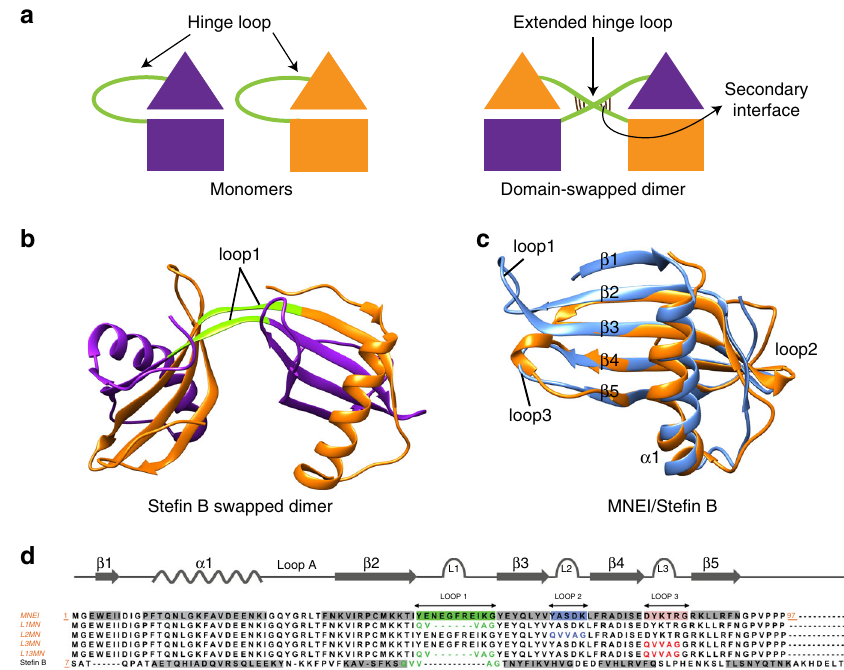
Fig. 1 Rational design of domain swapping in MNEI. a Schematic representation of domain swapping. The hinge loop, connecting the exchangeable domains, adopts an extended conformation in the swapped dimer. Each monomer-like half of the swapped dimer, formed by contributions from the two polypeptide chains (or protomers), is referred to as a “ functional unit ” . The proximal arrangement of the polypeptide chains in the domain-swapped conformation may lead to the formation of a novel intermolecular interface (secondary interface), which is not found in the monomeric structure. The secondary interface is shown in the cartoon as a set of new interactions established between the two polypeptide chains in the region of crossover. b Structure of the domain-swapped dimer of ste fi n B (PDB ID: 2OCT) is shown. The two polypeptide chains contributing to the dimer are shown in purple and orange. Sub-domains β 1- α 1-loopA- β 2 and β 3-loop2- β 4-loop3- β 5 are exchanged between the two protomers. Loop1 (green) containing the QVVAG stretch acts as the hinge loop. c Structural superposition of MNEI (PDB ID: 1IV7, blue) and ste fi n B monomer (PDB ID: 4N6V, orange) is shown. d Structure-based sequence alignment of residues 7 – 98 of Ste fi n B with the full sequence of MNEI (1 – 97) is shown. The MNEI variants designed in this study are also shown in the alignment. The secondary structures are indicated above the alignment in gray. The loop sequences are colored as green: loop1, blue: loop2, and red: